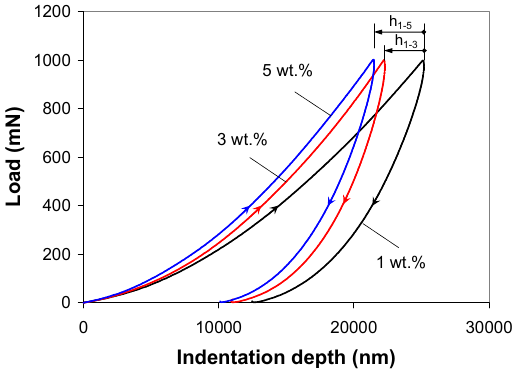
Figure 3. Experimental load–displacement response for 2-step indentation on the PP / MWCNT nanocomposites at 2000 mN / min loading / unloading rate.